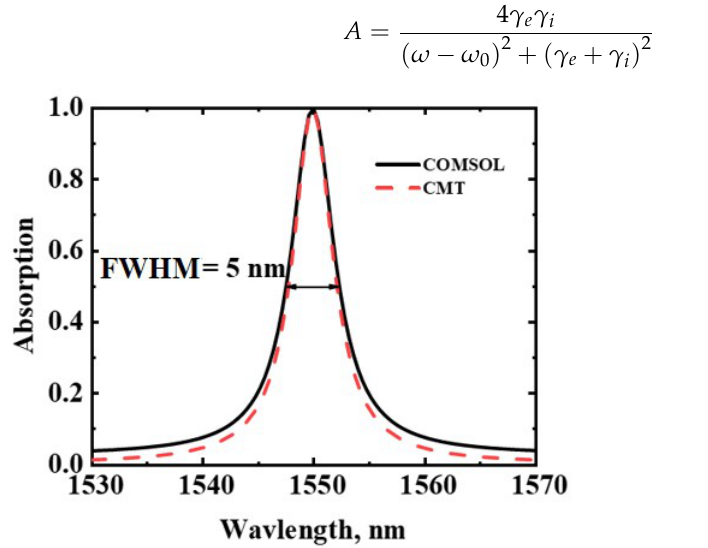
Figure 2. Absorption spectra of the MPA for x -polarized light at normal incidence condition. When the MPA is driven on resonance ( ω = ω 0 ), and the external leakage and intrinsic loss rates are the same ( γ e = γ i ), A equals to 1 which means critical coupling states is fulfilled, and all incident energy can be absorbed totally. The Equation (13) is used to fit the COMSOL calculated absorption spectrum, and they fit well with each other, as shown in Figure